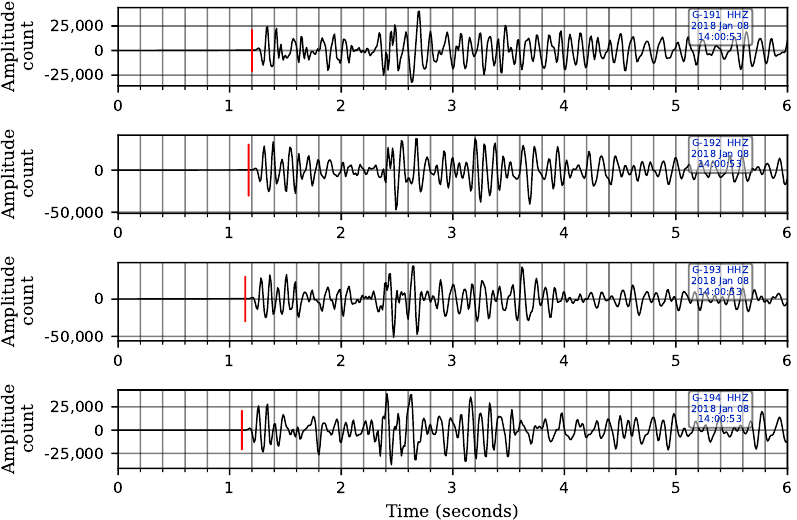
Figure 2. The moveout pattern of a genuine seismic event observed across the four geophone levels. The red vertical lines denote the first-arrival times of the seismic wave at each sensor. The wave arrives first at the deepest sensor and propagates upwards. A bandpass filter between 5–25 Hz has been applied to the records. Note that only vertical components are shown here for illustration. The waveforms are displayed in sequence with the waveform from the shallowest sensor at the top and the one from the deepest sensor at the bottom.